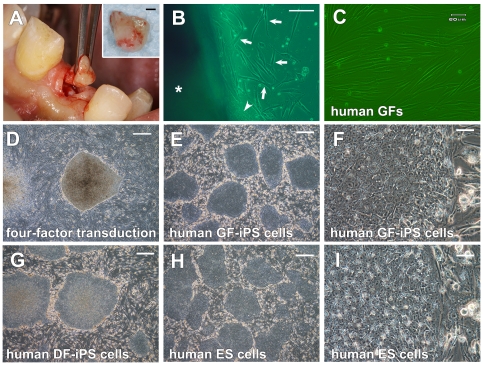
Generation of human GF-derived iPS cells.(A) Resection of gingival tissue from the adult patient during dental implant surgery. The resected gingival tissue (inset: scale bar; 1 mm) is generally treated as biomedical waste. (B) Fibroblasts (arrow) and epithelial cells (arrowhead) migrated out of the human gingival tissue (asterisk). Scale bar; 100 µm. (C) The morphology of established hGFs (Passage 4). Scale bar; 60 µm. (D) The morphology of a colony derived from hGFs 26 days after transduction of the four factors. Scale bar; 500 µm. (E–I) Morphology of (E and F) clonal hGF-derived iPS cells (clone 547A-1), (G) human dermal fibroblast-derived iPS cells (DF-iPS cells) and (H and I) human KhES-3 ES cells. Scale bars; 500 µm for E, G and H, and 50 µm for F and I.